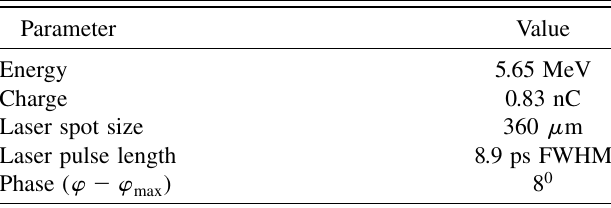
TABLE IV. Parameters of the beam corresponding to the best brightness result.